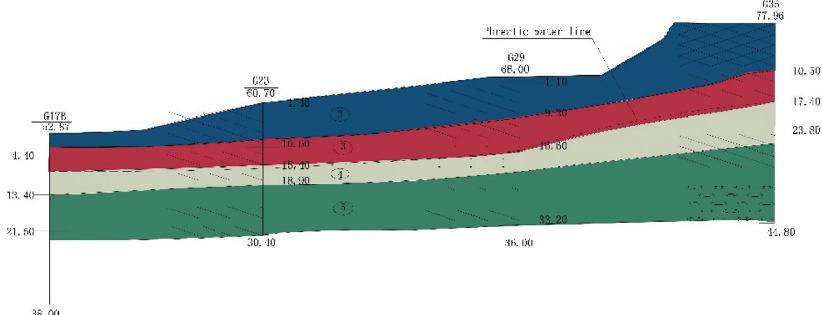
Figure 2: Schematic diagram of slope